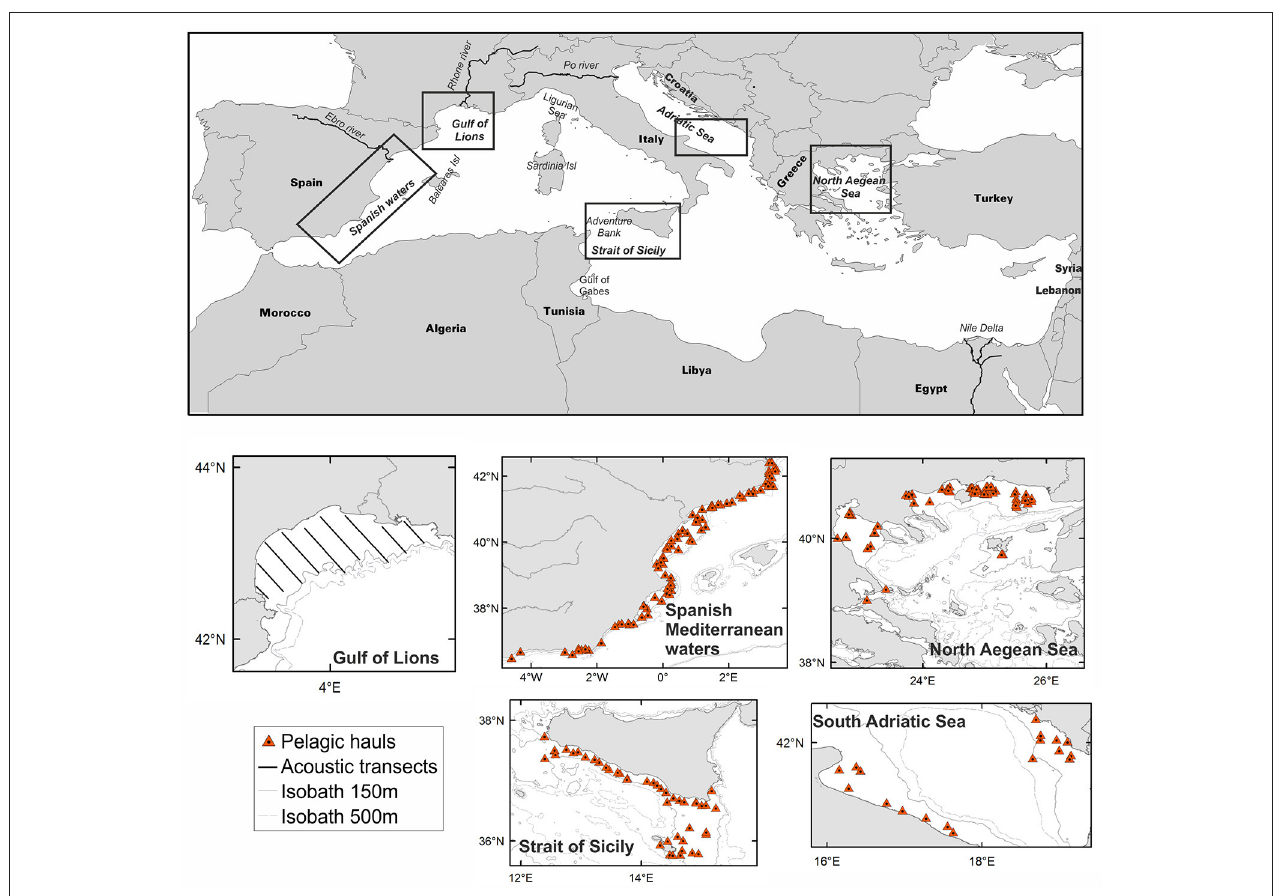
FIGURE 1 | Map of the study areas. Acoustic transects in the Gulf of Lions and the position of pelagic trawls held within acoustic surveys used for analysis in each study area are shown. Toponyms mentioned in the text as well as the position of the main rivers and bathymetry are also indicated.